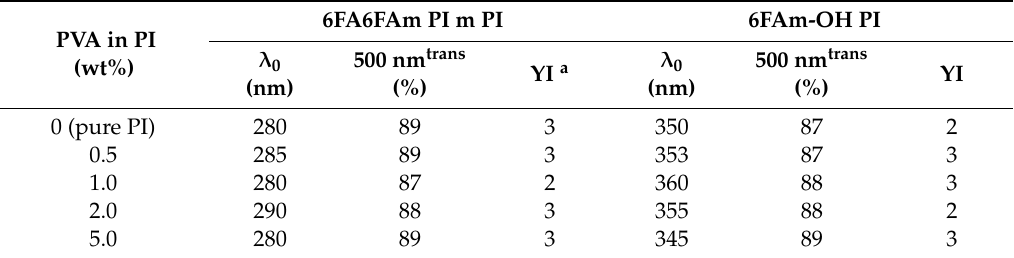
Table 2. Optical transparencies of CPI membrane films with various PVA